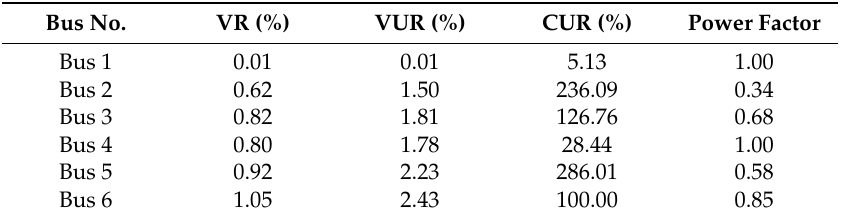
Figure 11. Power flow of Case 4. Table 5. Test result of Case 4.